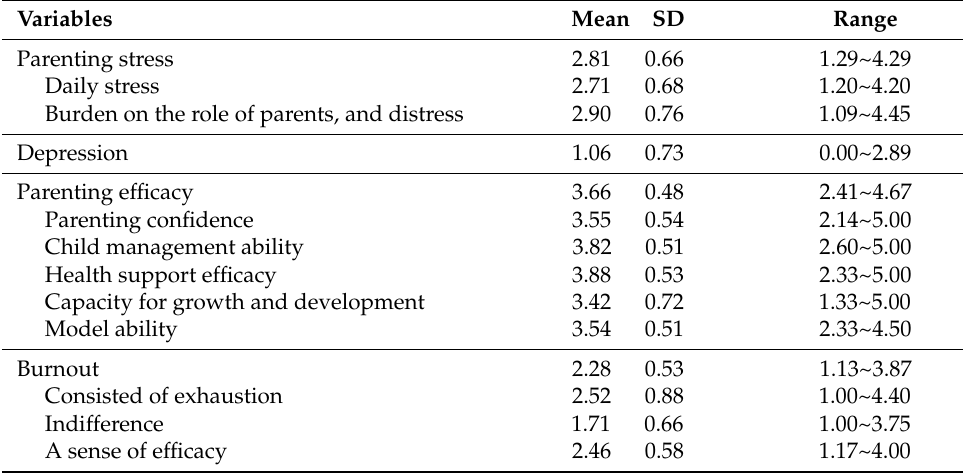
Table 2. The descriptive statistics of the research